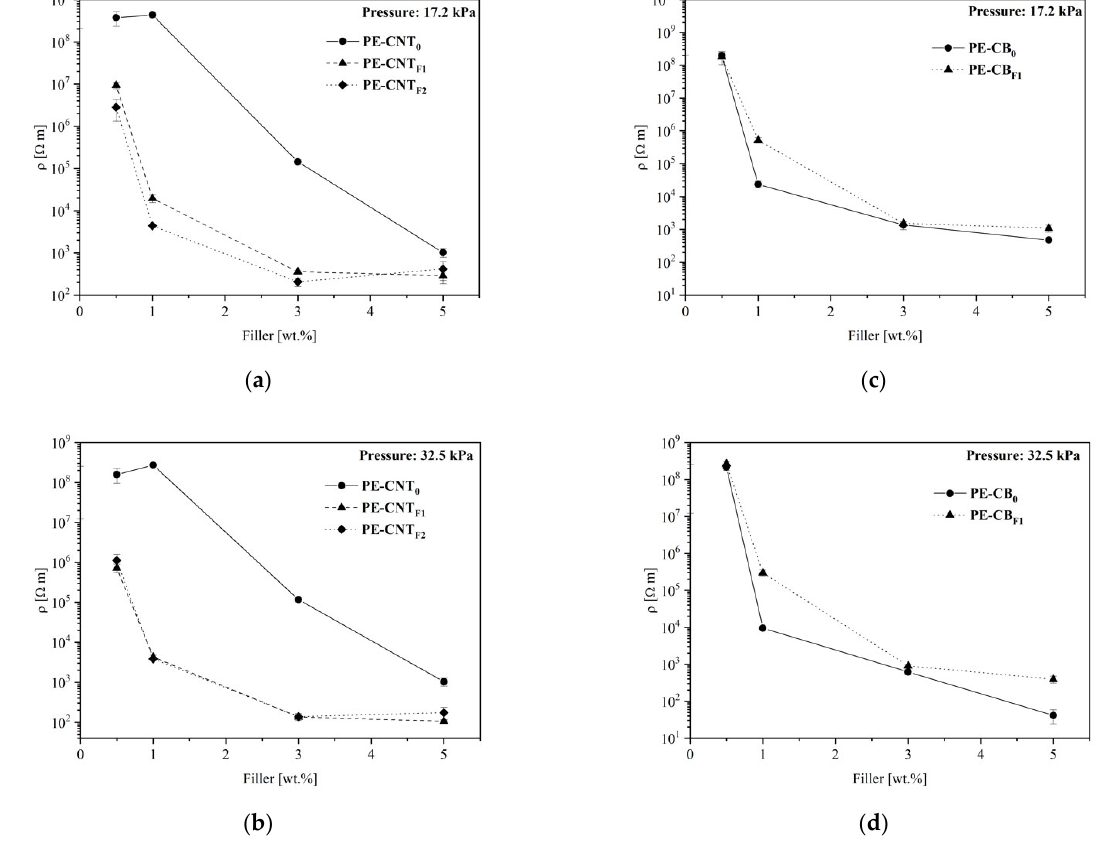
Figure 2. Electrical resistivity of UHMWPE-based nanocomposites as a function of the filler contents at two different applied pressures: 17.2 kPa ( a , c ) and 32.5 kPa ( b , d ). Trends referred to as PE-CNT 0 , PE-CNT F1 and PE-CNT F2 are reported in plots ( a , b ); those related to PE-CB 0 and PE-CB F1 are shown in plots ( c , d ).